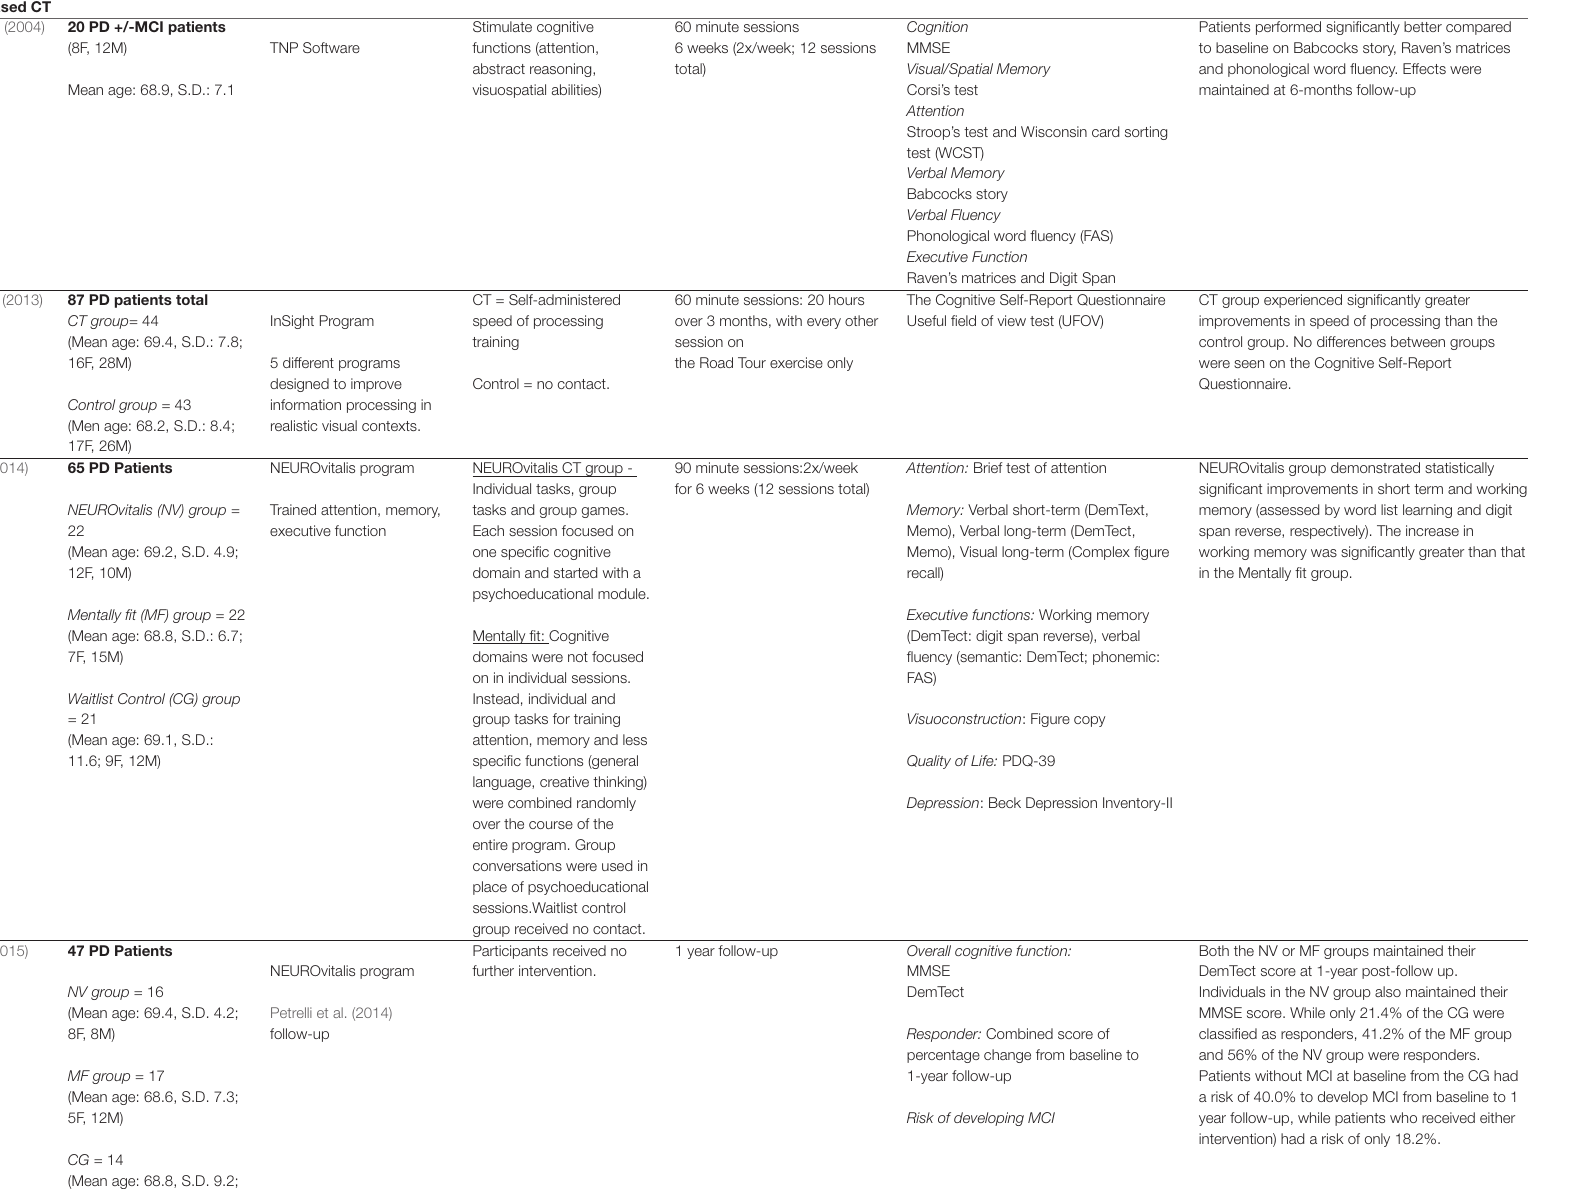
NEUROvitalis group demonstrated statistically significant improvements in short term and working memory (assessed by word list learning and digit span reverse, respectively). The increase in working memory was significantly greater than that in the Mentally fit